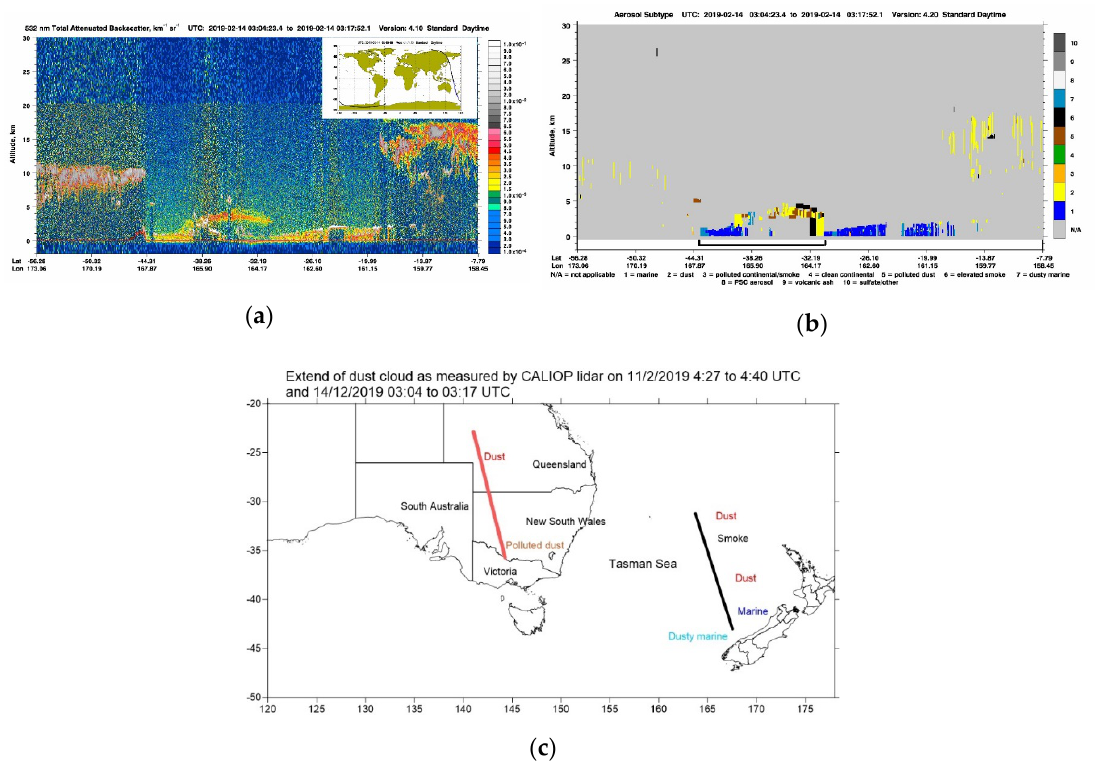
Figure 12. ( a ) LiDAR 532 nm total attenuated backscatter vertical structure on 14 February 2019 from 03:04 to 03:17 UTC with CALIPSO satellite path (inset) above the Tasman Sea near New Zealand. ( b ) Aerosol subtype vertical profile as derived from CALIOP measurements with dust as yellow and smoke as black. ( c ) Extent of aerosol layer clouds as measured by CALIPSO satellite on 11 February 2019 (red line) and on 14 February 2019 (black line). The labels correspond to aerosol types at the location indicated.